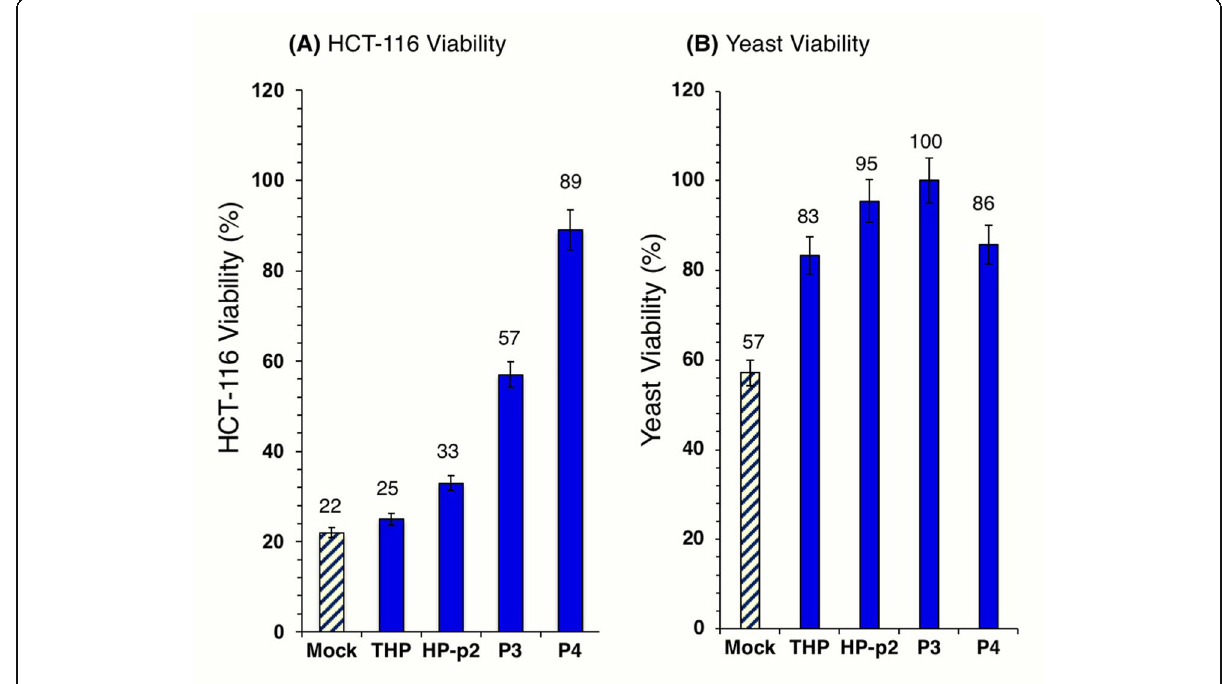
Fig. 6 Viability of HCT-116 ( a ) and yeast ( b ) cells oxidized with DEM or H 2 O 2 , respectively. Cell viability of DEM-treated HCT-116 was measured using trypan blue exclusion assay ( a ). Viability of H 2 O 2 -treated yeast cells was measured by colony counting on YPD agar plates ( b ). Viability was represented as survival percentage to the non-induced